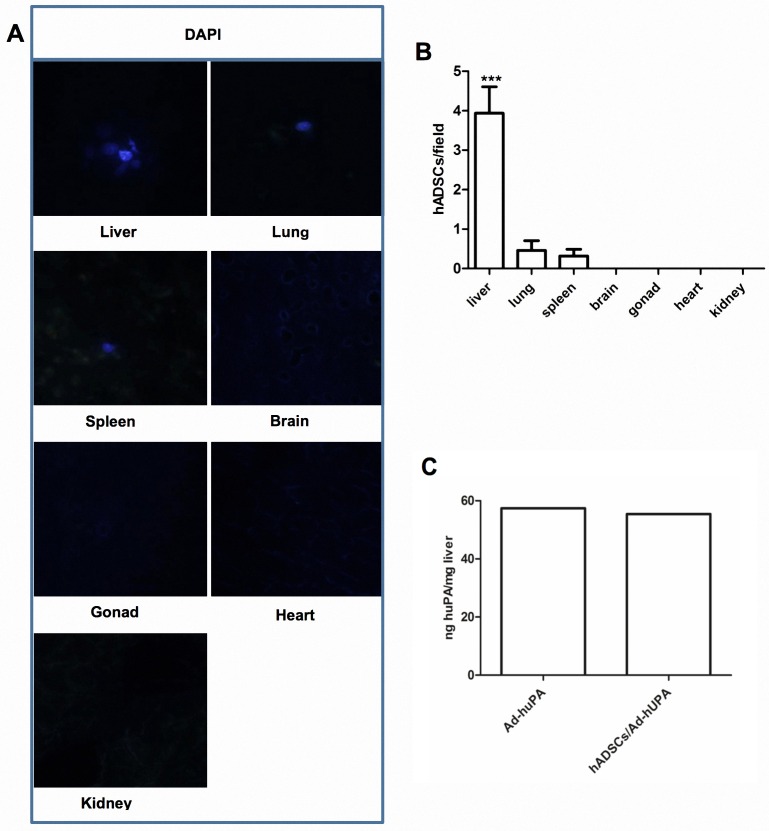
Biodistribution of hADSCs in cirrhotic rats.(A) DAPI-stained cells transplanted via iliac vein were detected mainly in liver, and in a very low frequency in lung and spleen. (B) Quantification of DAPI-positive cells per field of view in collected organs (***P<0.001). (C) huPA protein levels in liver homogenates of cirrhotic rats treated with Ad-huPA or the combination of hADSCs and Ad-huPA. Data represent the median for each group.